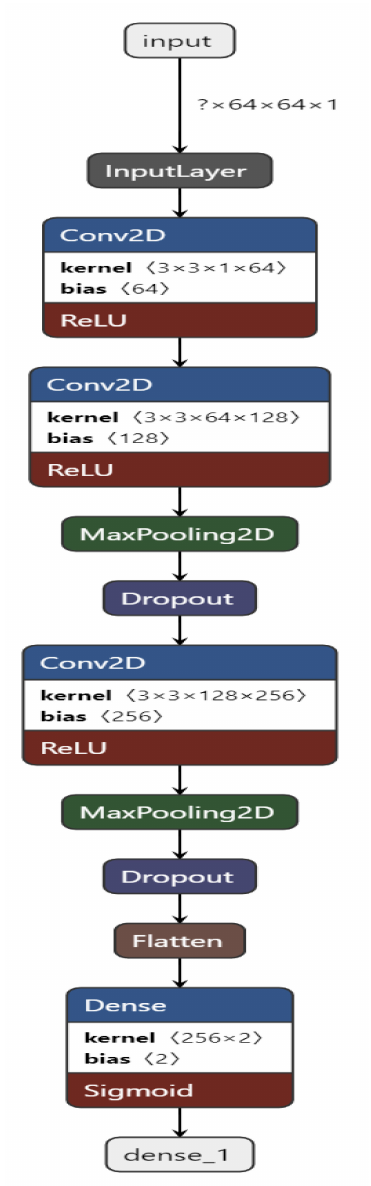
Figure 3. Convolutional Neural Network structure for the proposed